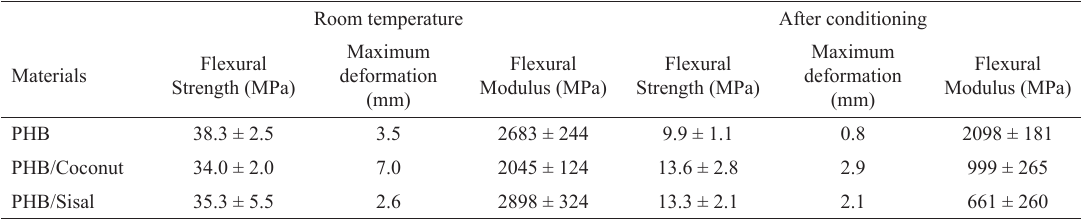
Table 5: Data of flexural strength (MPa), maximum deformation (mm) and modulus (MPa) obtained by the average curve of the flexural test PHB unreinforced and reinforced composites with coconut fibers and sisal fibers.